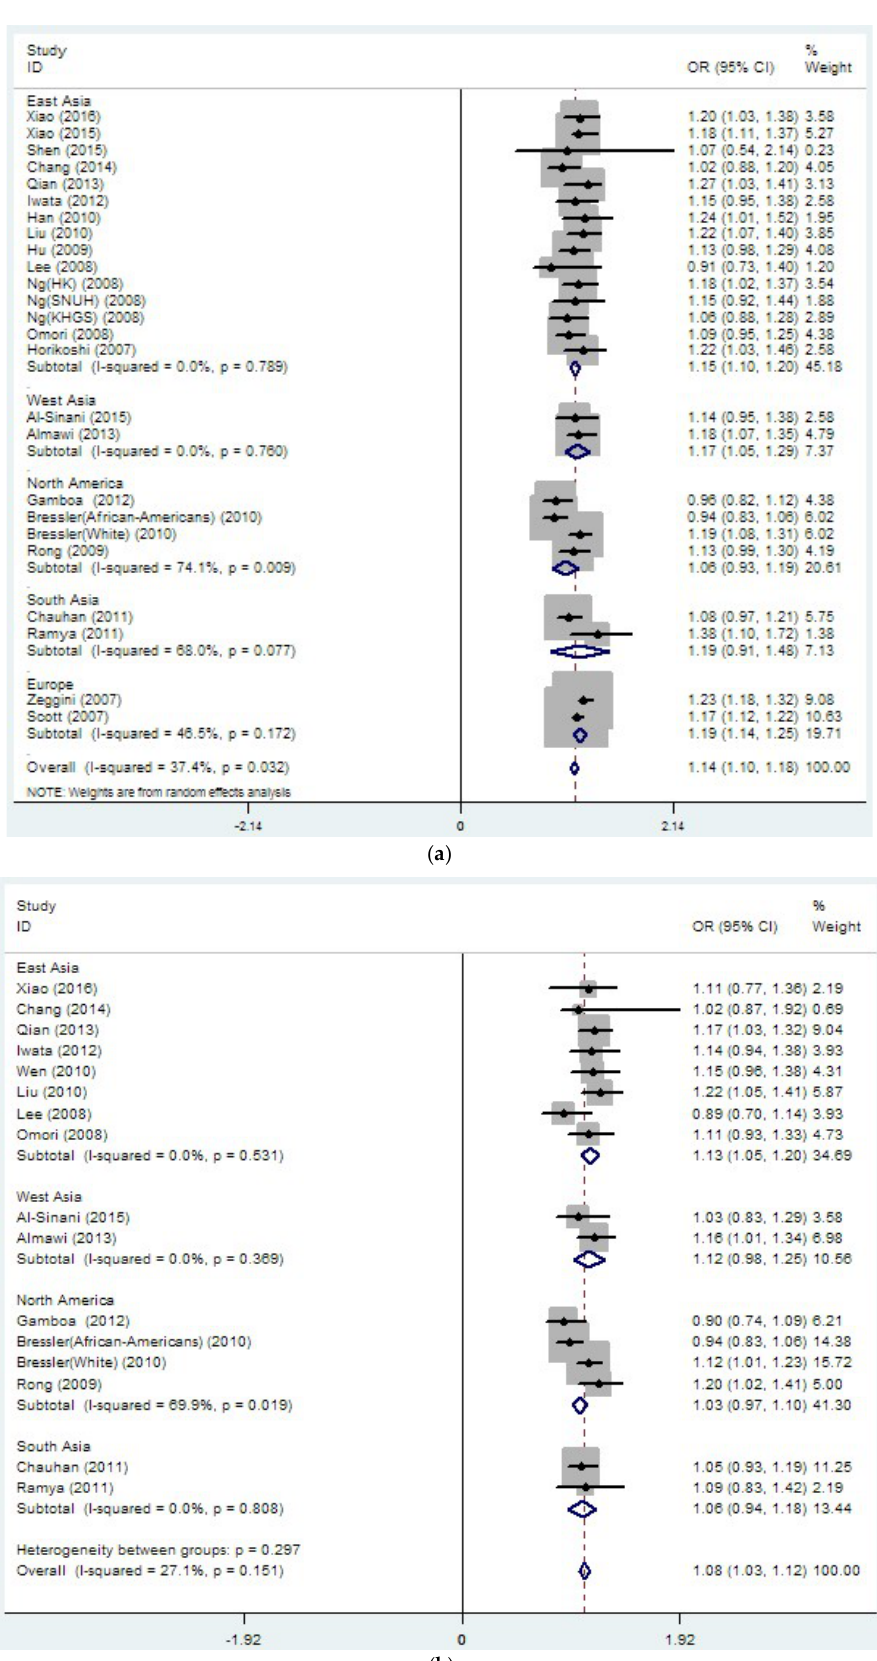
Figure 2. Meta-analysis for the associations between rs8050136 and Type 2 diabetes mellitus (T2DM) risk: ( a ) without; and ( b ) with adjustment for body mass index (BMI).